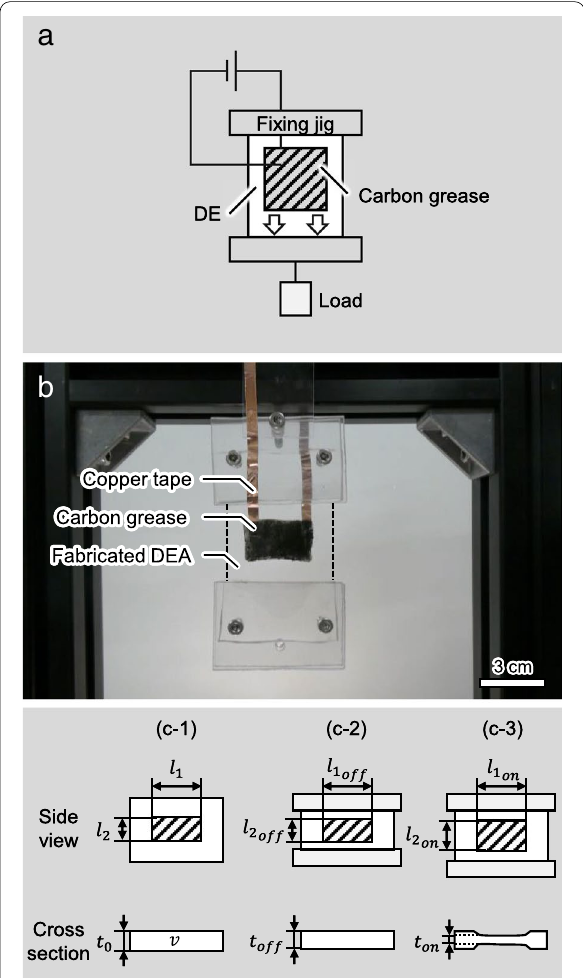
Fig. 1 Experimental system of uniaxial load. a Schematic figure of the experimental system, b picture of the actual experimental system, c schematic figures of deformation of a DEA with uniaxial